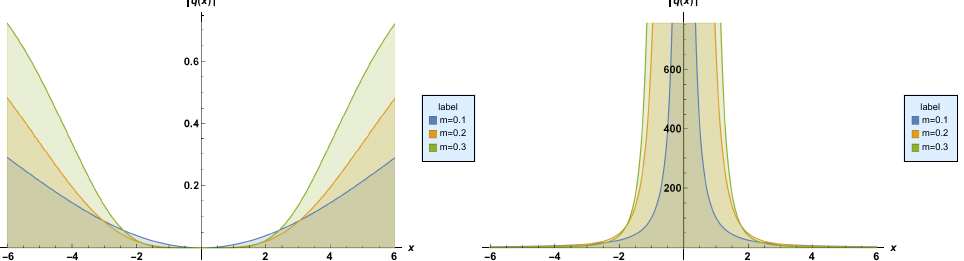
Figure 6. Profiles of stationary dark and singular solitons,